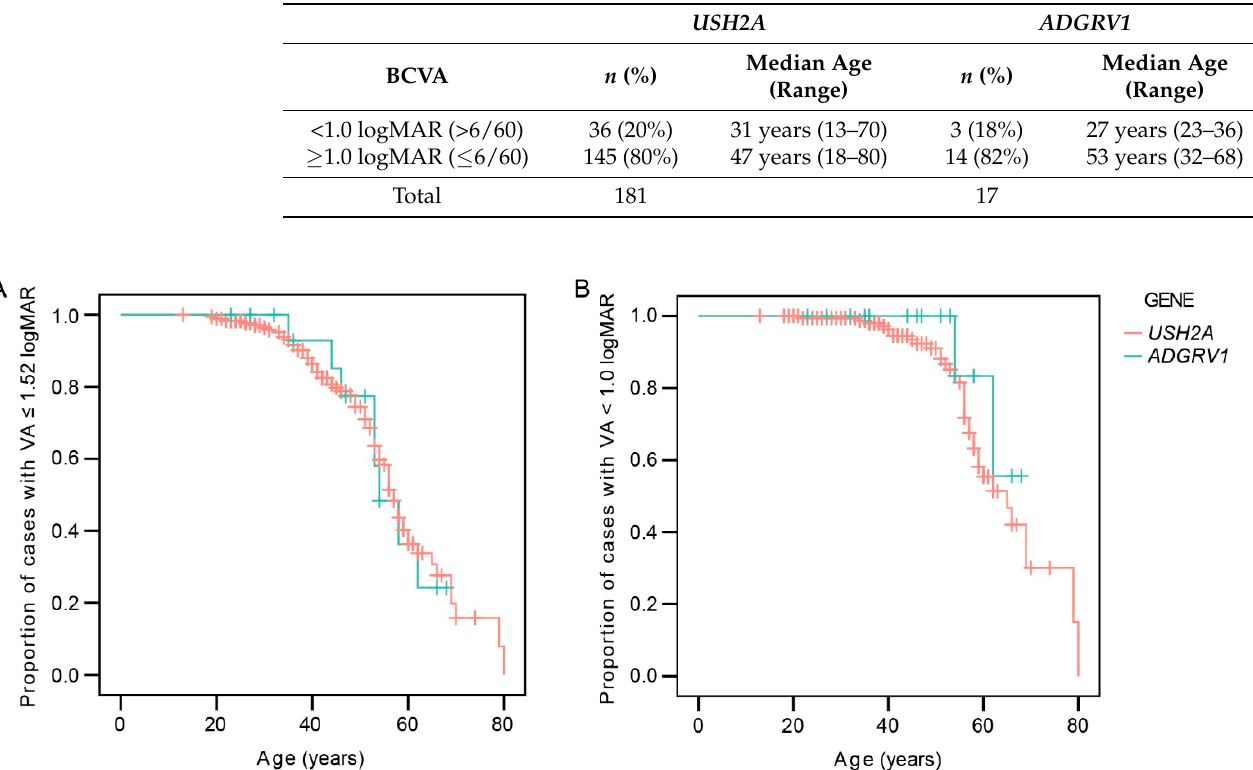
Figure 2. Kaplan–Meier survival analysis showing the ratio of patients reaching low vision (>1.52 logMAR or <6/20) ( A ) or legal blindness ( ≥ 1.0 log MAR or ≤ 6/60) ( B ). Red color represents USH2A patients and green color represents ADGRV1 patients.